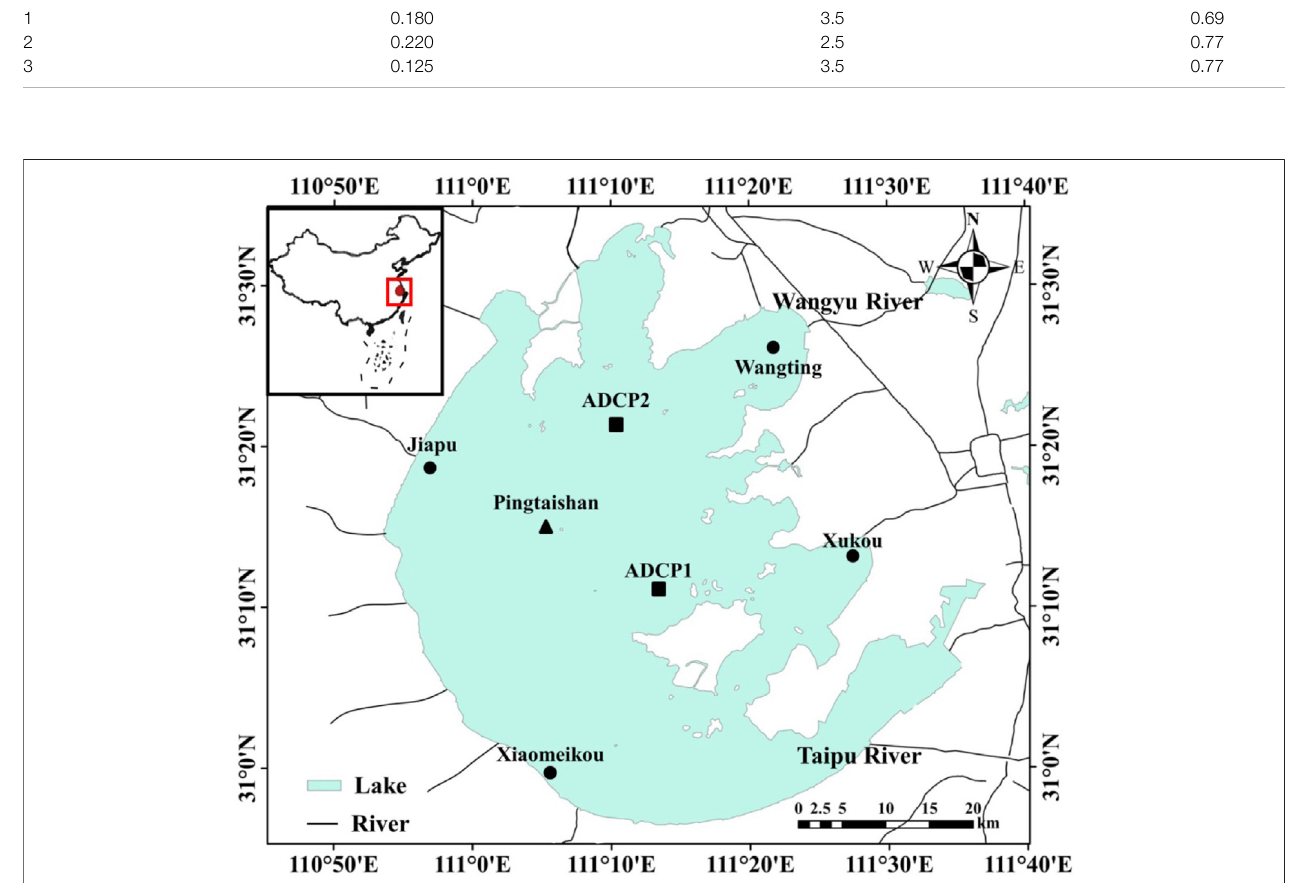
FIGURE 3 | Geographical location of the study area, surrounding rivers, and monitoring points (where circular points are water-level veri fi cation points; square points are speed veri fi cation points; triangle points are wave height veri fi cation points).